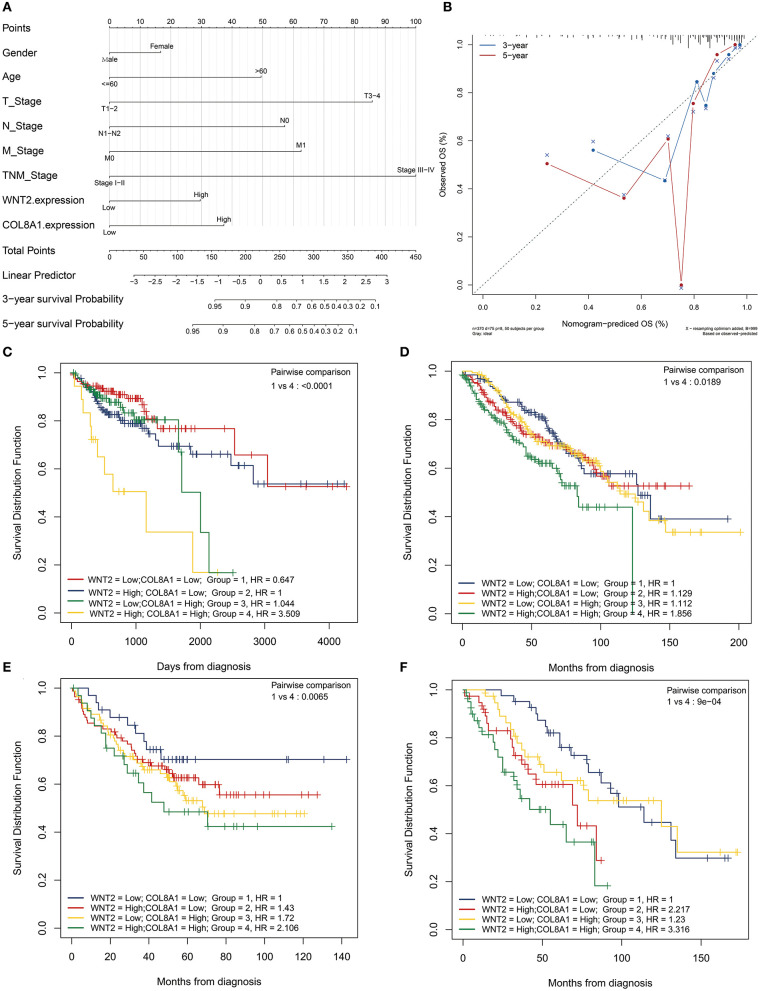
Prognostic value of Wnt2 and COL8A1 in COAD. (A) Prognostic nomogram for COAD based on clinical features, and Wnt2 and COL8A1 expression levels. (B) Calibration curves for clinical prediction model curves for the association of Wnt2-based prognostic score with clinicopathological variables. (C) Patients with low Wnt2 and COL8A1 expression have a better prognosis compared to patients with high Wnt2 and COL8A1 expressions in the TCGA cohort. (D) patients from GSE17538 cohort. (E) Patients from GSE39582 cohort. (F) Patients from Jiangnan University cohort.